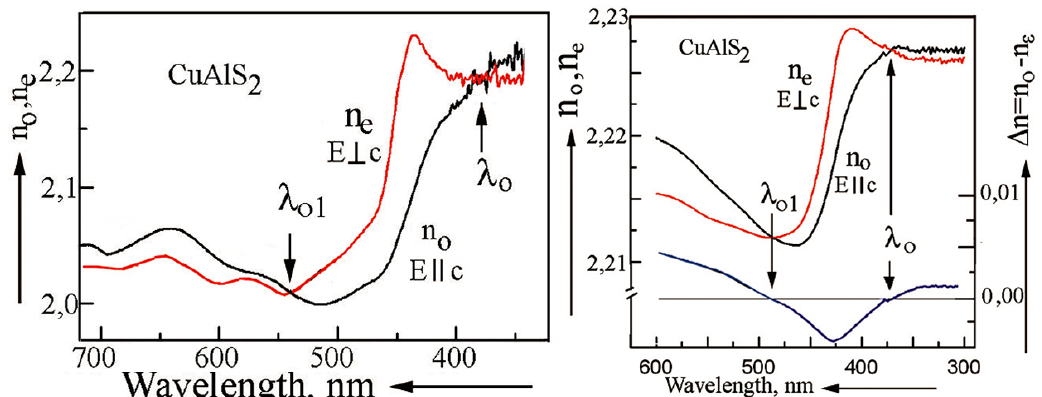
Figure 5. Spectral dependences of refractive indices for ordinary and extraordinary waves in CuAlS crystals with thicknesses of 223 µm (left) and 35 µm (right). 2